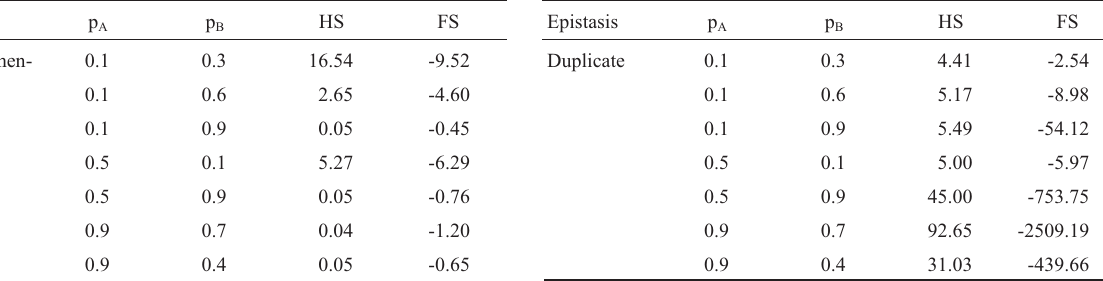
Table 4 - Bias (%) in the estimate of the additive variance because of the fitting of the additive-dominant model when there is digenic epistasis,